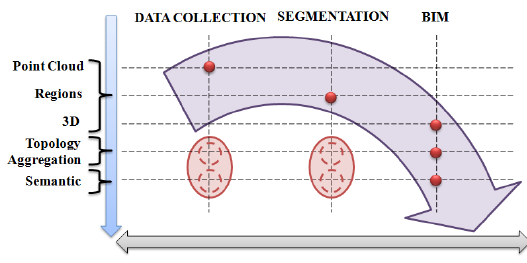
Figure 2: The proposed approach which suggest enriching the final 3D model at the beginning of the process by defining relations and attributes at the phases of data collection and segmentation